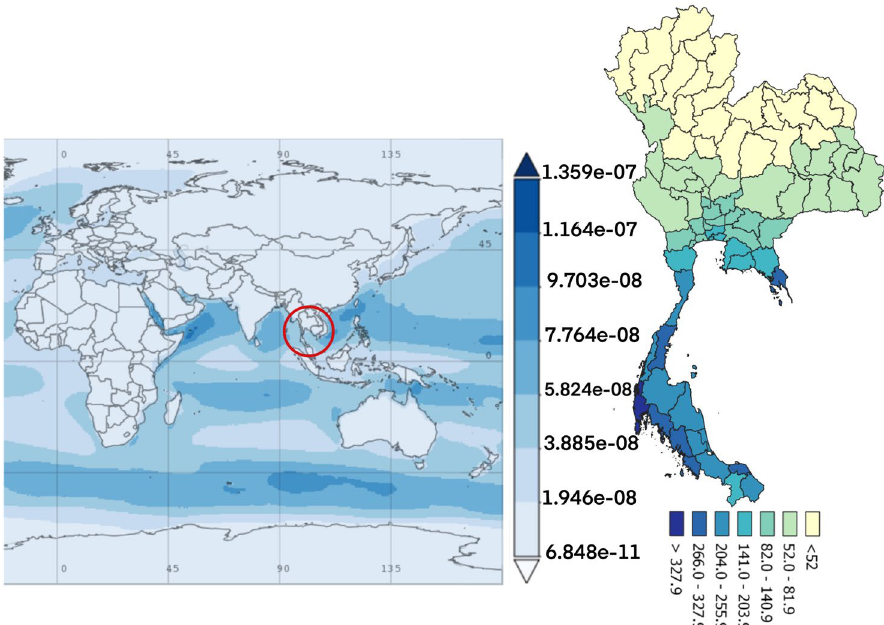
Figure 6. The average time of sea salt concentration monthly over 2010–2016. (The world map was generated by Giovanni Version 4.34: a free and open source earth data, https ://giova nni.gsfc.nasa.gov/giova nni/) and accumulated dose between 2010 and 2016 in Thailand (Thailand map was generated by QGIS software: a free and open source geographic information system, https